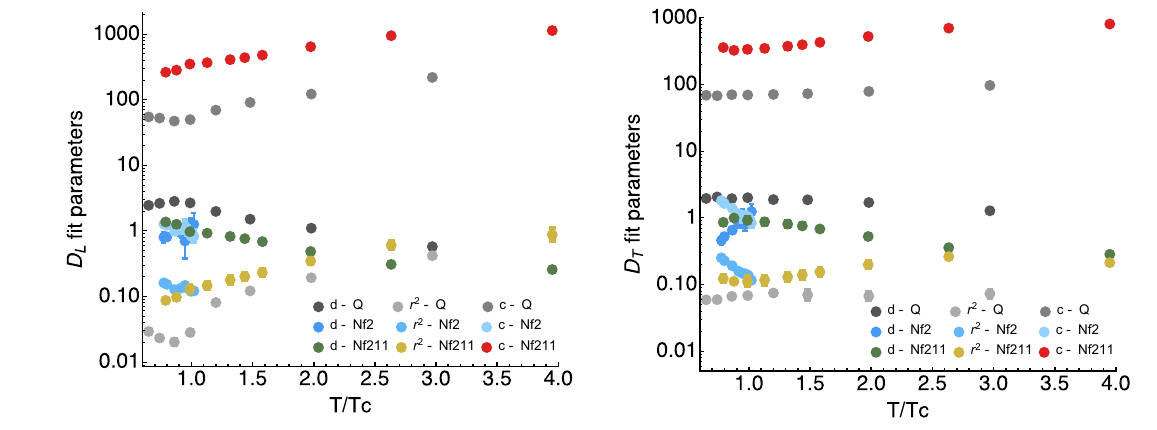
Fig. 2 Comparison of the Stingl-fit parameters c / a 2 (top points), d / a 2 (middle points) and r 2 a 2 (bottom points) obtained from quenched QCD (gray shades), from N f = 2 full QCD (light blue shades) and our N f = 2 + 1 + 1 full QCD (red, yellow, green). Note that the results from quenched QCD and N f = 2 + 1 + 1 show qualitatively consistent